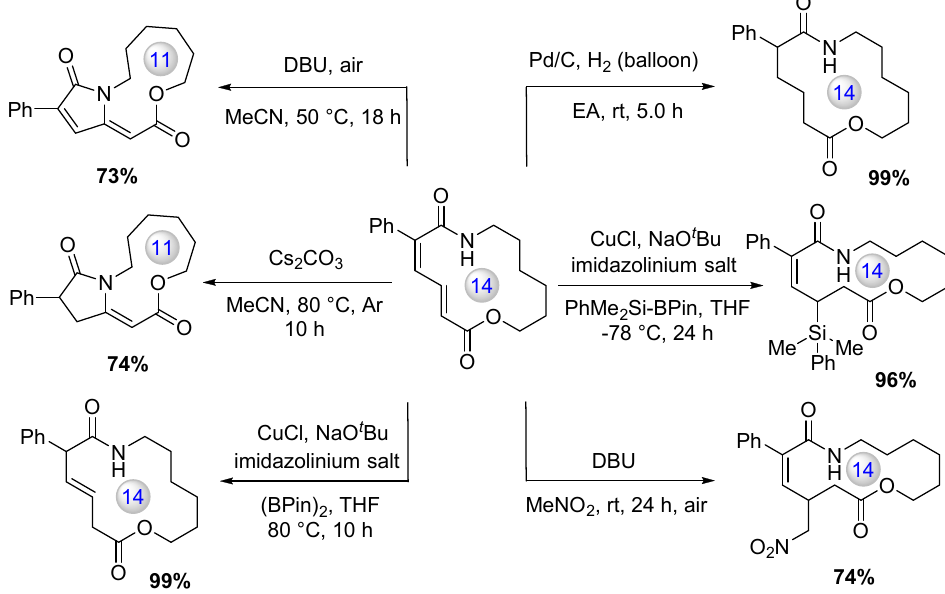
Figure 5. Synthetic derivatization of the cross ‐ coupling macrocycle product [56].